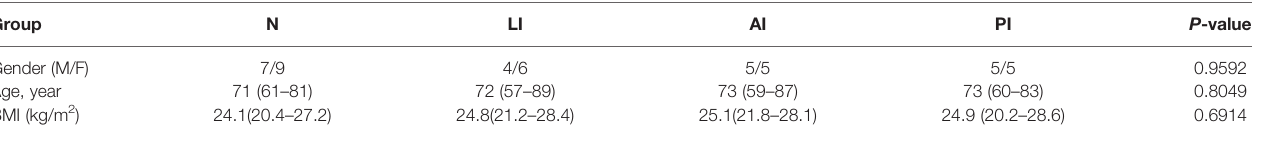
TABLE 1 | Characteristics of each